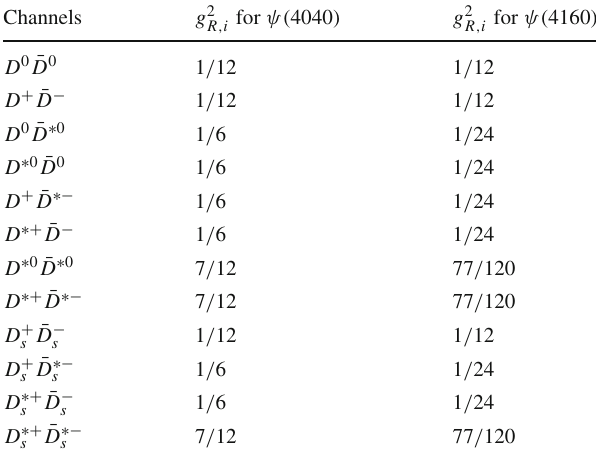
values for ψ( 4040 ) and ψ( 4160 ) vector mesons